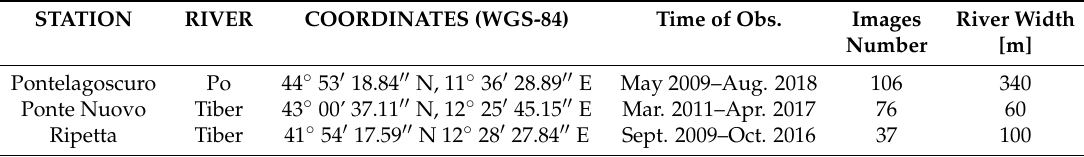
Table 1. Satellite datasets used in the analysis and corresponding river gauged stations STATION